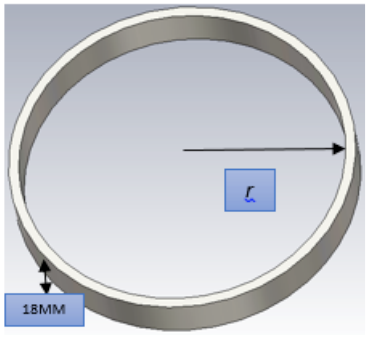
Figure 2 : Metallic Loop Like